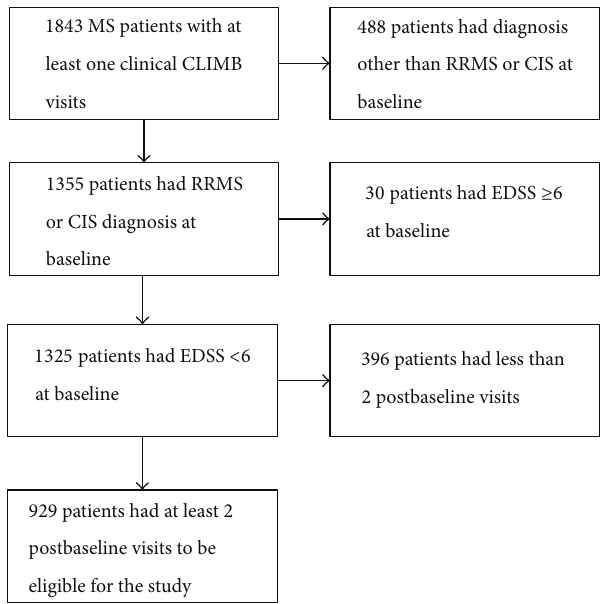
Figure 1: Flow chart for selection of patients included in